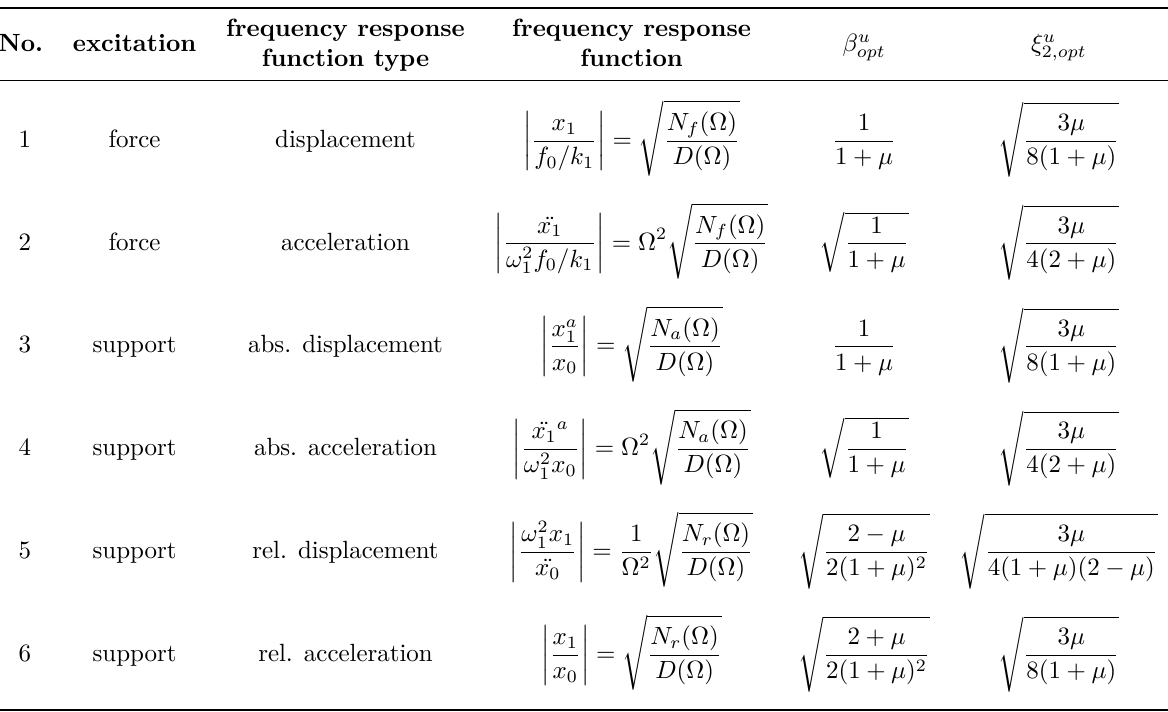
Table 1. Optimum parameters of TMD based on the fixed-point method.